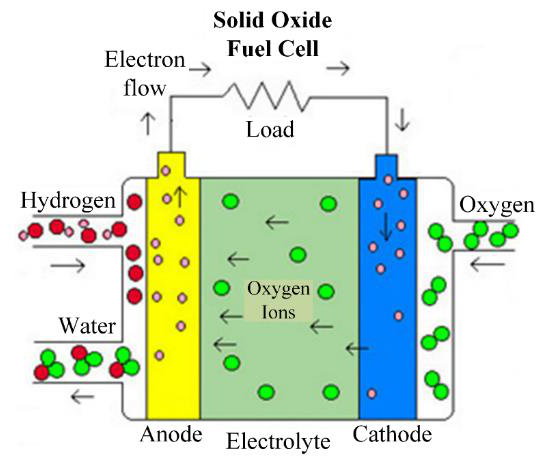
Figure 69. Operational schematic of solid oxide fuel cell; solid zirconium oxide stabilized with yttria oxide is used as the electrolyte, whereas hydrocarbons such as methane (CH4) and carbon monoxide mixture is used as the fuel in this type of fuel cell [209].